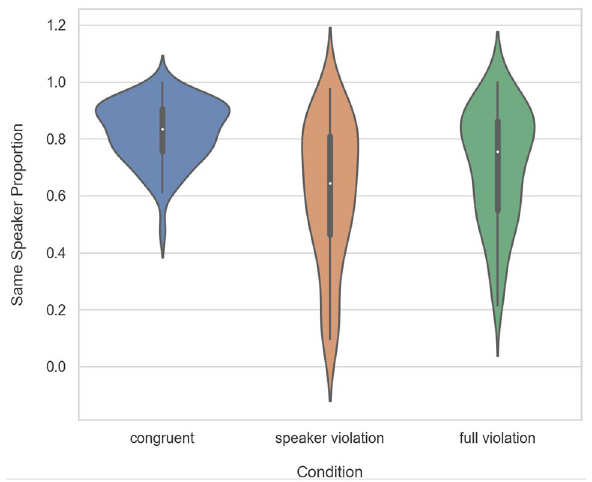
Figure 1. Violin plot showing the proportion of stimuli perceived as spoken by the same speaker in the congruent , speaker violation and full violation conditions in Experiment 1. The white dot indicates the median, the thick gray line represents the interquartile range, and the thin gray line represents the rest of the distribution barring outliers. The overall shape indicates the kernel density estimation of the underlying distribution.